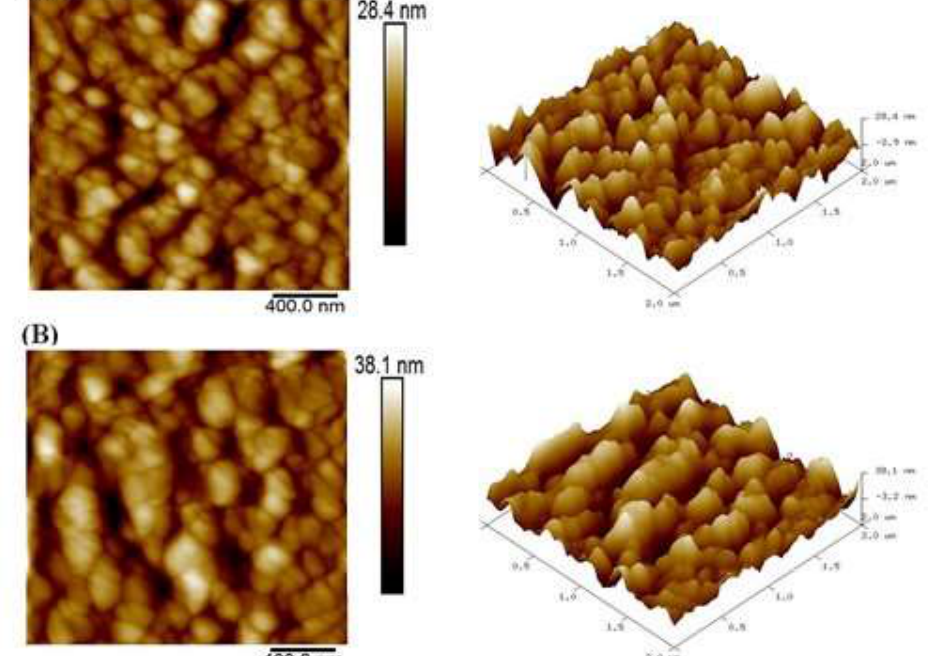
Figure 3: Surface topography of ZnO NP films prepared in the glove box surface processed at (A) 100 o C for 10 min, surface roughness is 8 nm, and (B) 350 o C for 1h, surface roughness is 15